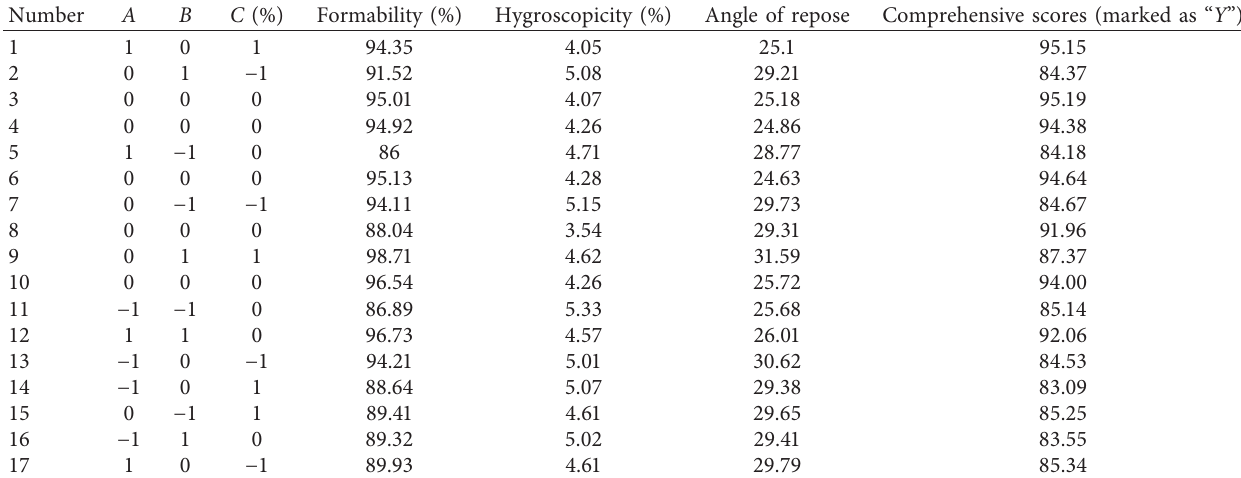
Table 3: Experimental design and results of response surface for granulation process.